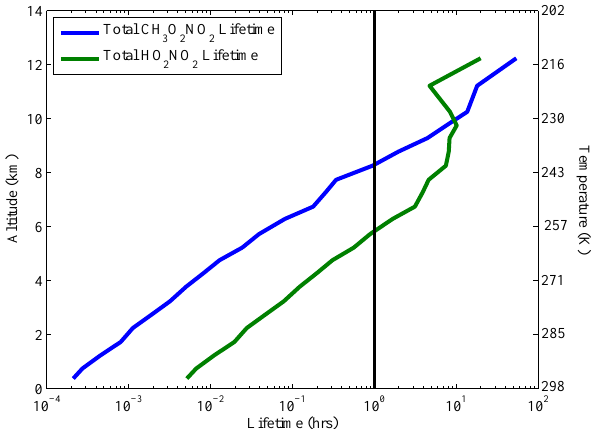
Figure 1. Calculated mean total lifetime profile of CH 3 O 2 NO 2 (blue) and HO 2 NO 2 (green) for typical conditions observed during DC-3 in the daytime. The total lifetime is calculated using observed OH, photolysis rates, and temperatures along with the rate constants listed in Table 2 and measurements in Table 3. The black line marks the region where the non-acyl peroxy nitrates have a lifetime longer than 1h.